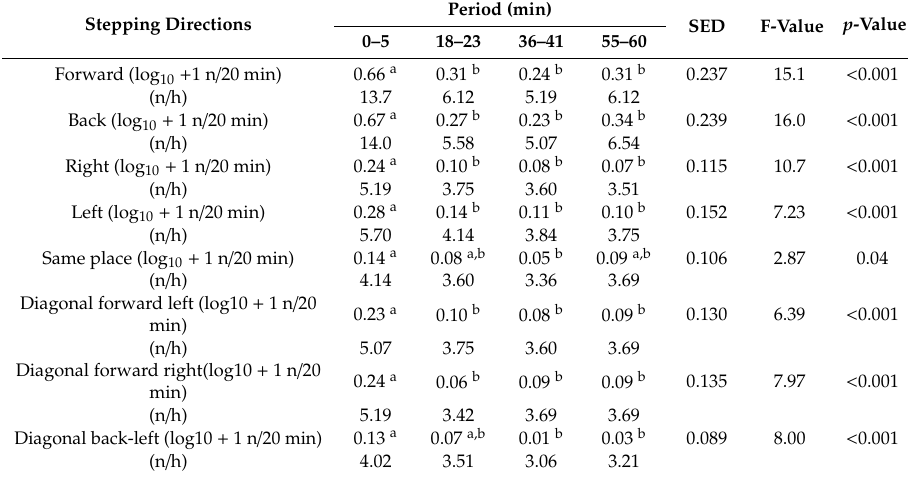
Table A2. Significant interactions between total stepping directions and time period (minutes